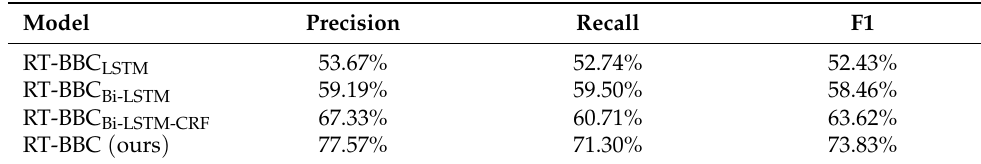
Table 5. Overall entity recognition results of the four